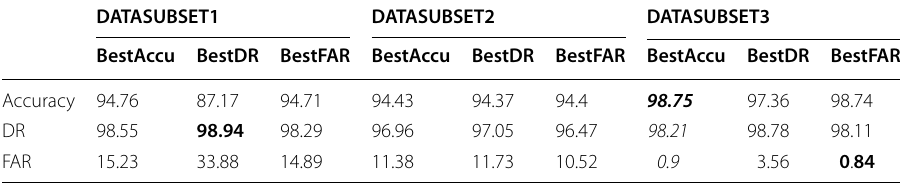
Table 6 Comparison of overall accuracy, detection rate and false alarm rate for different data subsets DATASUBSET1